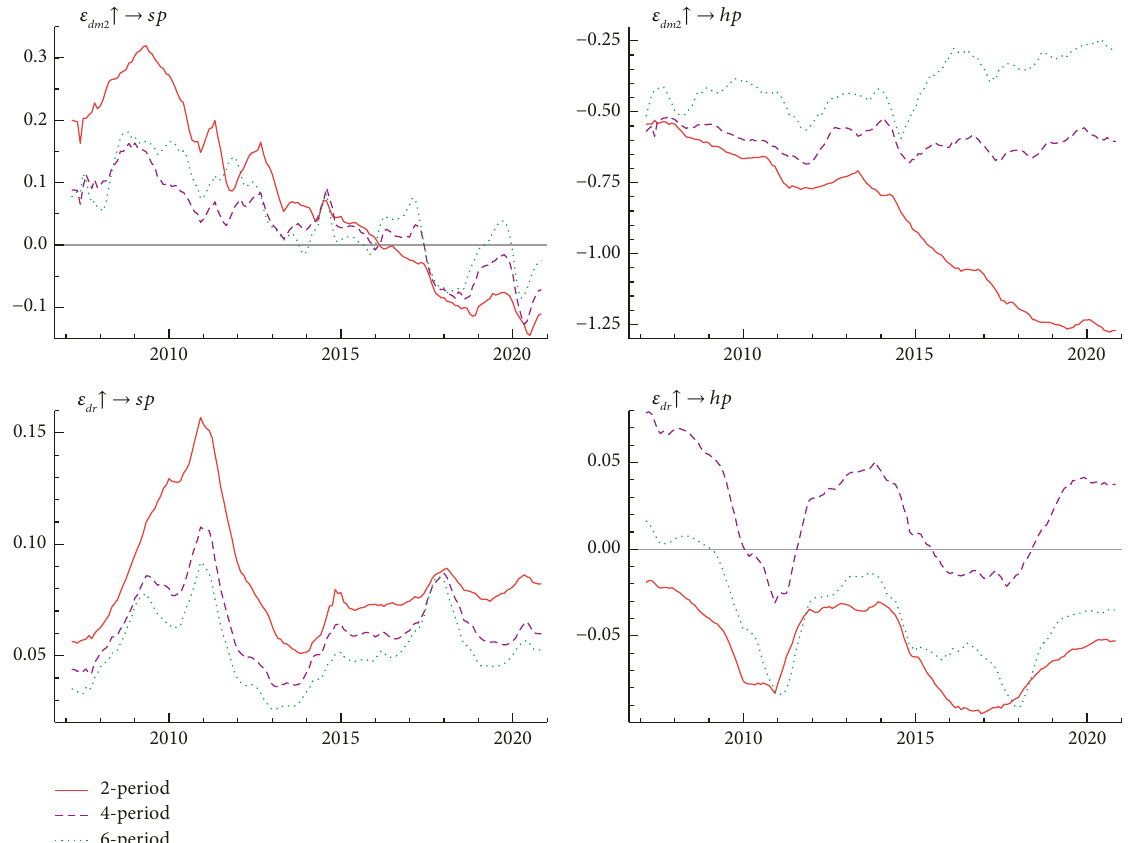
Figure 8: The impulse responses of monetary policy to asset price volatility with an equal